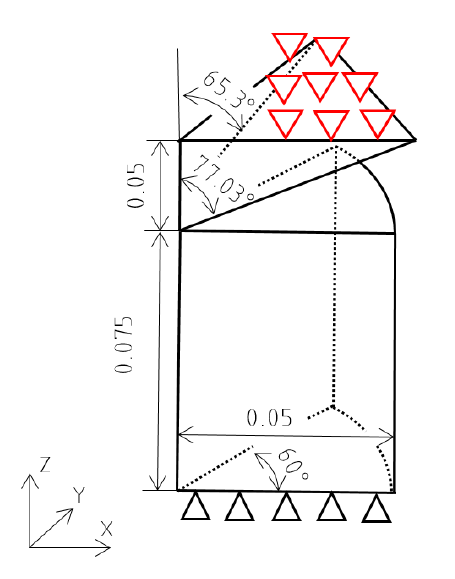
Figure 1. Geometry of the indenter and specimen [mm].